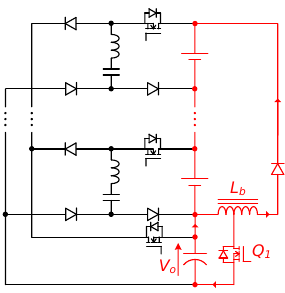
Figure 11. Use of a tapped inductor in the buck-boost stage to achieve a higher voltage conversion ratio.